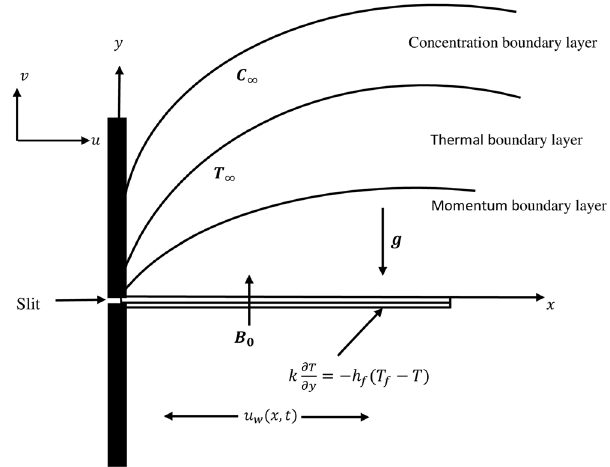
Figure 1. Physical model and coordinate